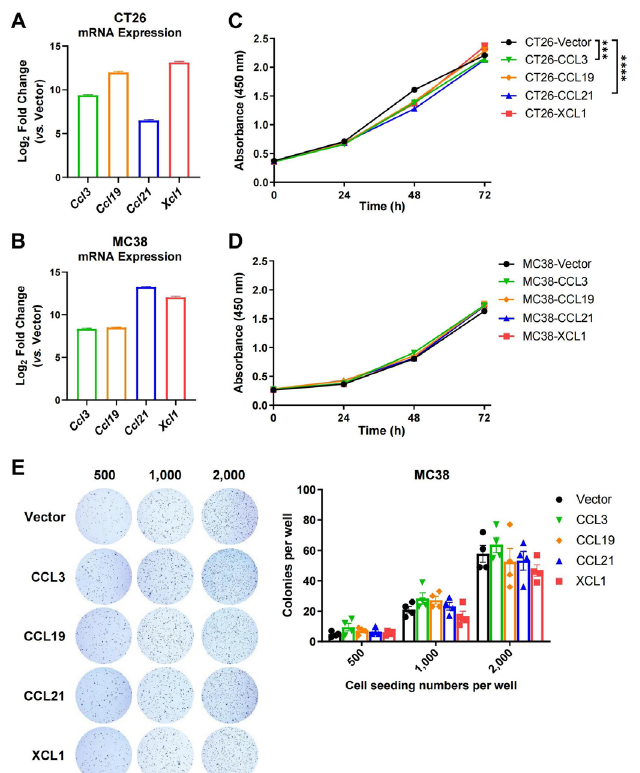
Figure 2. Chemokine overexpression hardly affects tumor cell proliferation or survival. A. and B. The expression of mouse chemokine genes ( Ccl3 / Ccl19 / Ccl21 / Xcl1 ) in CT26 (A) and MC38 (B) cell lines was confirmed by quantitative PCR (qPCR, n = 4−5); C. and D. CCK-8 assay was used to quantify the amount of CT26 (C, n = 3) and MC38 cells (D, n = 5) overexpressing chemokines or vector over a 72-h culture period; E. representative images for colony formation assay and statistics of colony numbers of MC38 overexpressing chemokines or empty vector at indicated seeding densities ( n =